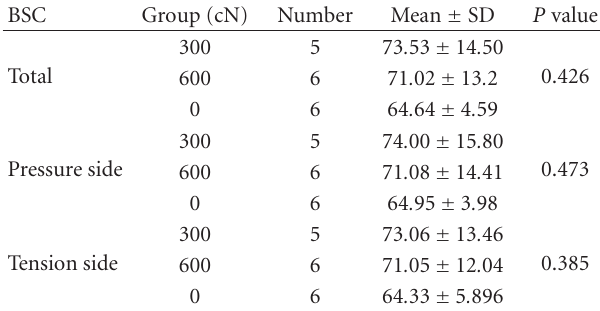
Table 1: Statistical indices of total bone-mini-screw contact, at tension side and pressure side of 300 cN, 600 cN, and control group